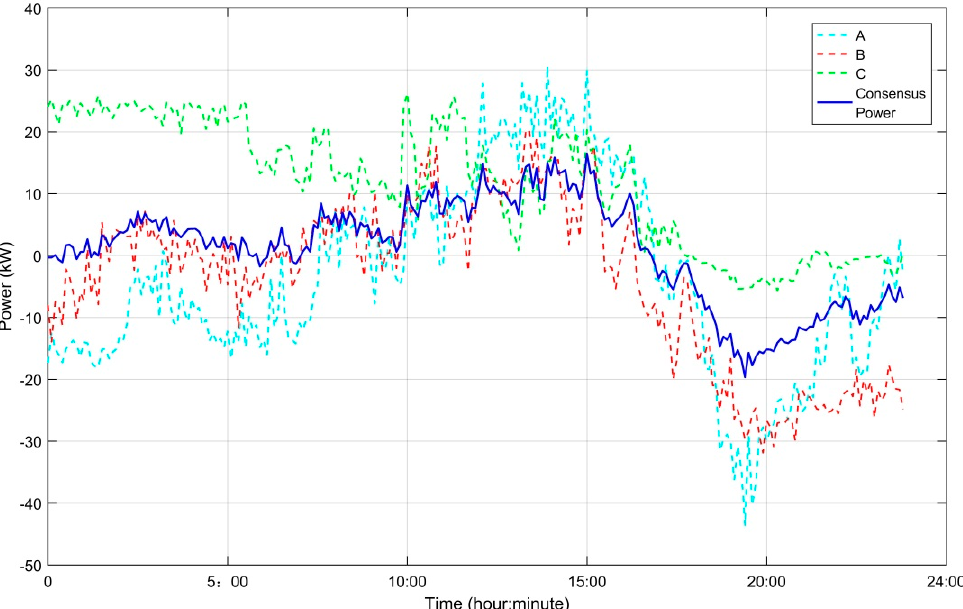
Figure 25. Battery power.